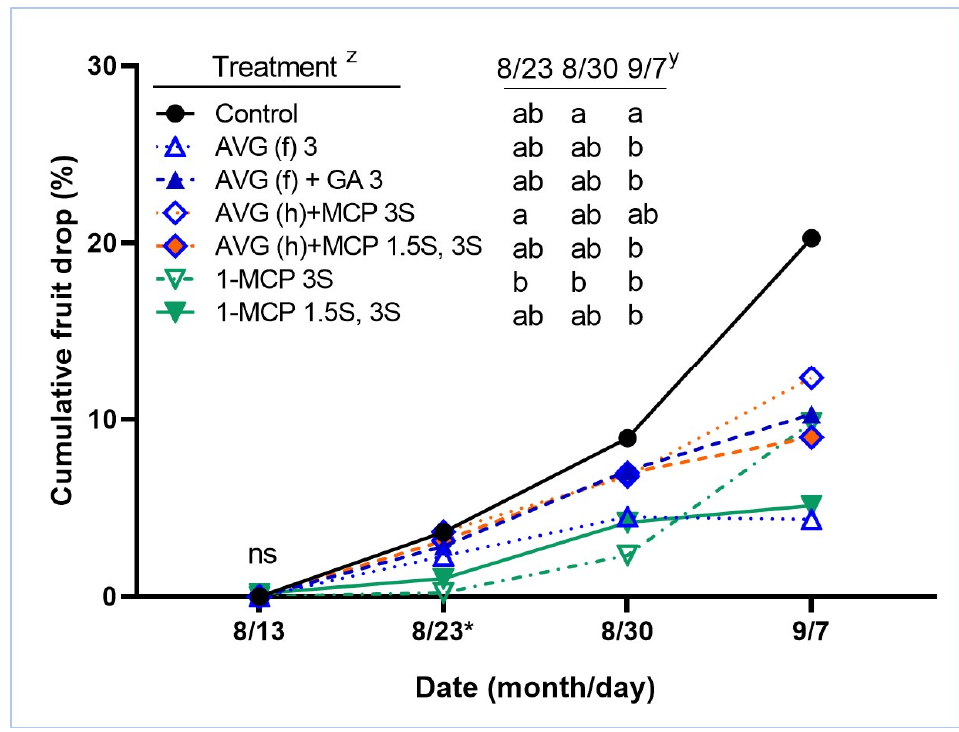
Figure 3. Effects of AVG and 1-MCP on preharvest fruit drop of ‘Buckeye Gala’ apples ( n = 6). Z, h represents half-rate (65 mgL − 1 ) of AVG; f, full-rate (130 mgL − 1 ) of AVG; GA, GA 4+7 ; s, single application of 1-MCP at starch pattern index (SPI) = 1.5 and/or 3. Numbers in each treatment indicate the